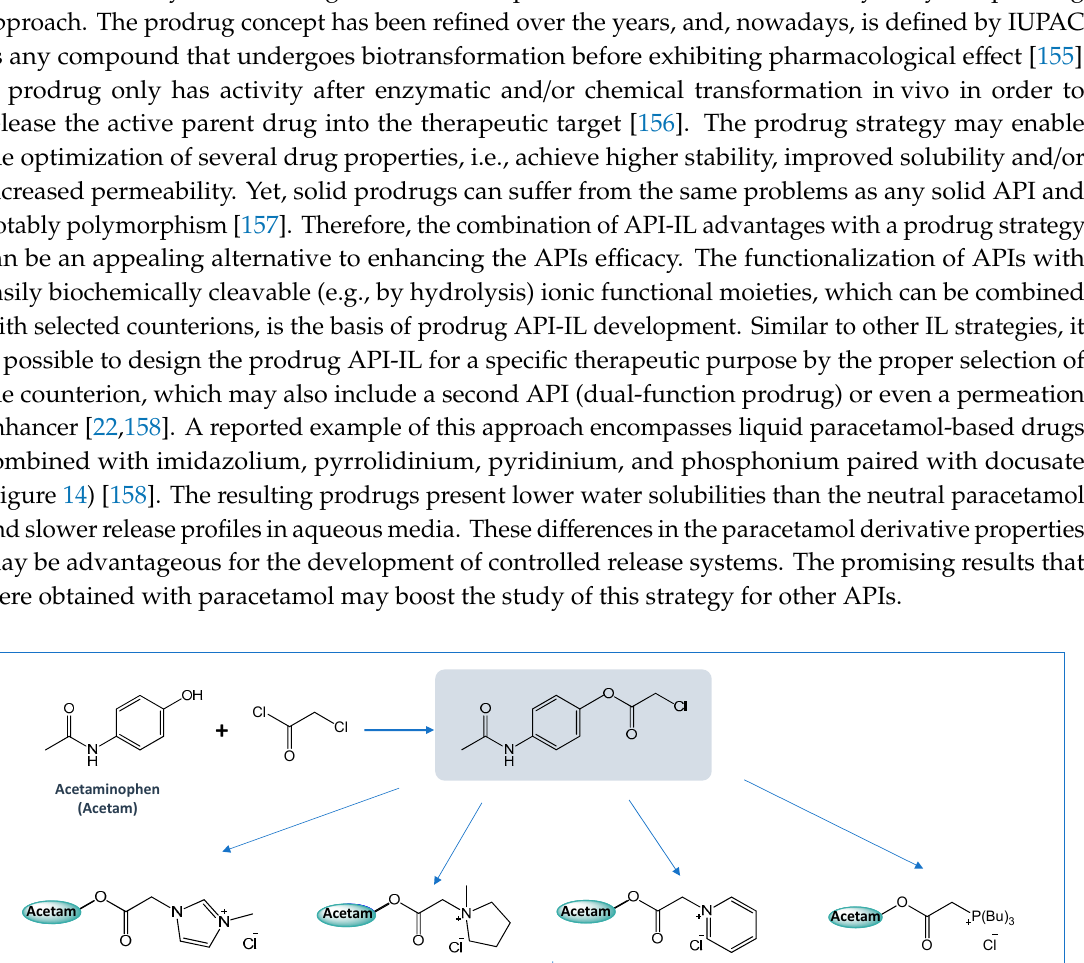
Figure 14. Synthesis of cationic acetaminophen prodrug ILs paired with the docusate anion proposed in [158].